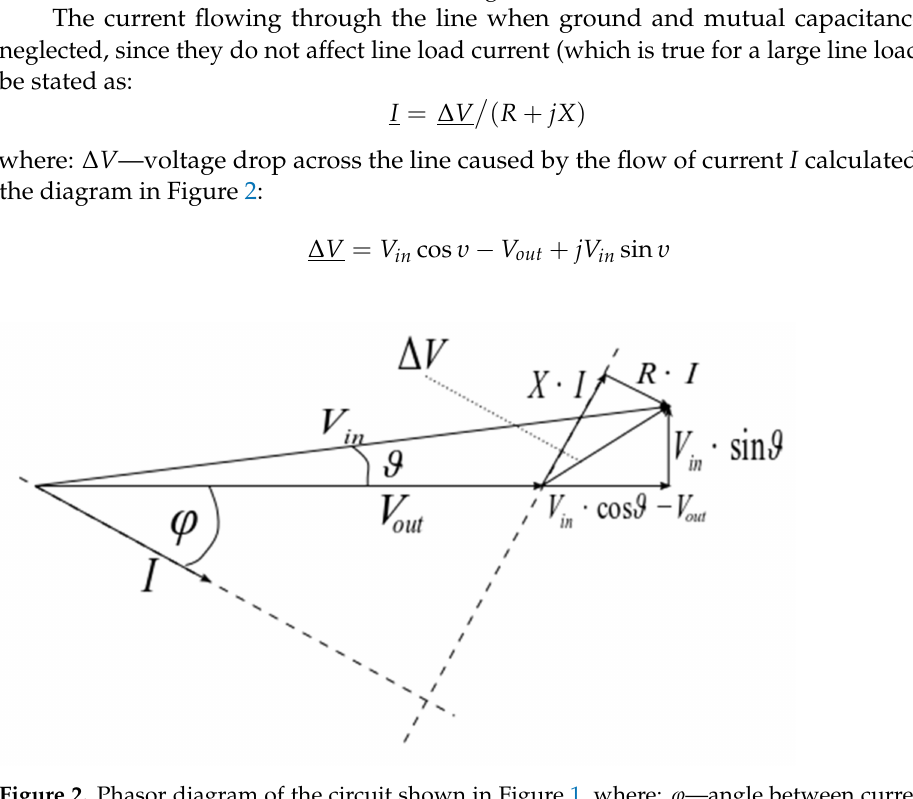
Figure 2. Phasor diagram of the circuit shown in Figure 1, where: ϕ —angle between current and output voltage, and υ —angle between V l n and V out